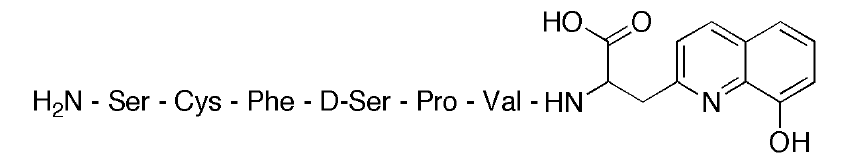
Figure 5. Fluorescent zinc sensor containing 8-HQ and minimized, a zinc finger protein-based peptide sequence.